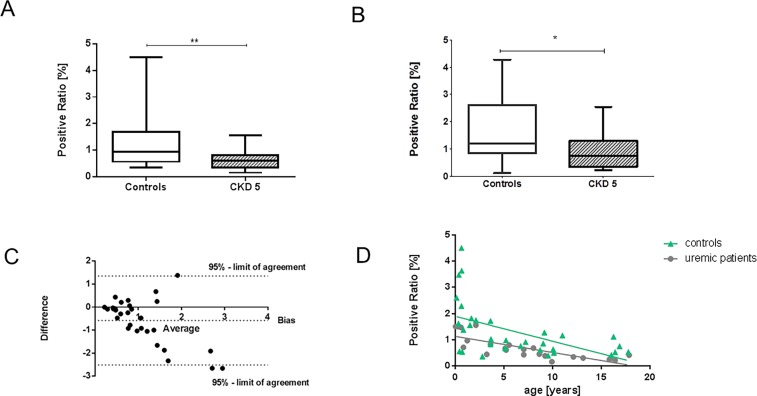
Microvascular density of omental tissue from children with CKD 5 and controls.Box plots of manual (A) and (B) automatic imaging measurements showing significantly decreased microvascular density in CKD patients. Positive ratio [%] denotes the percentage amount of tissue area staining positive with the CD31 marker. * p< 0.05 **p<0.01, Mann-Whitney test. (C) Bland-Altman graph showing degrees of agreement of measurements by both methods. (D) Linear regression analysis of microvascular density and age for patients with CKD (r = -0.83, p = <0.0001) and controls (r = -0.56; p = 0.001).